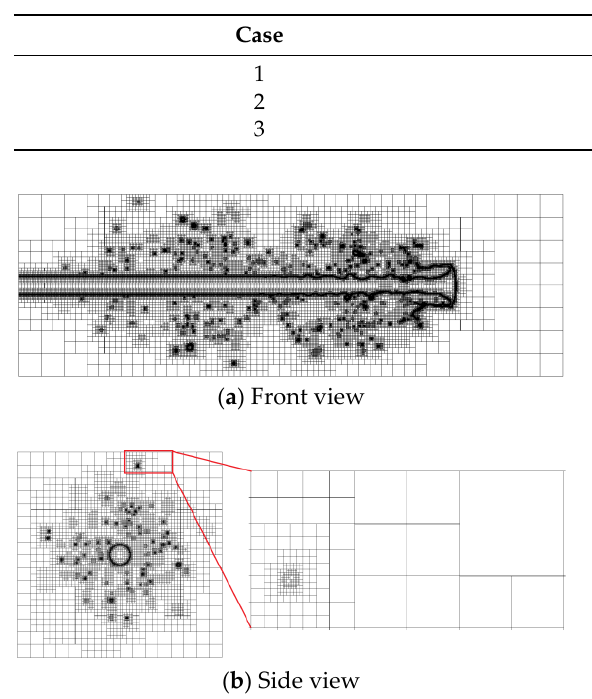
Figure 2. Schematic of the adaptive mesh refinement.